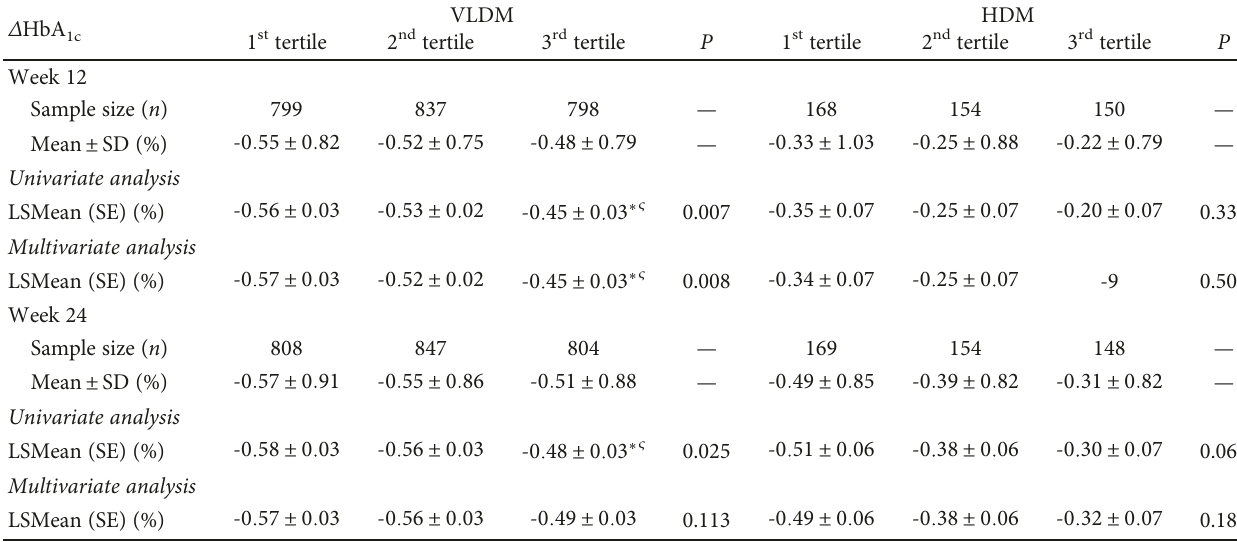
Table 2: Δ HbA at weeks 12 and 24 for patients of the 3 TG-based tertiles in the VLDM and HDM groups (FAS LOCF). 1c Δ HbA 1c